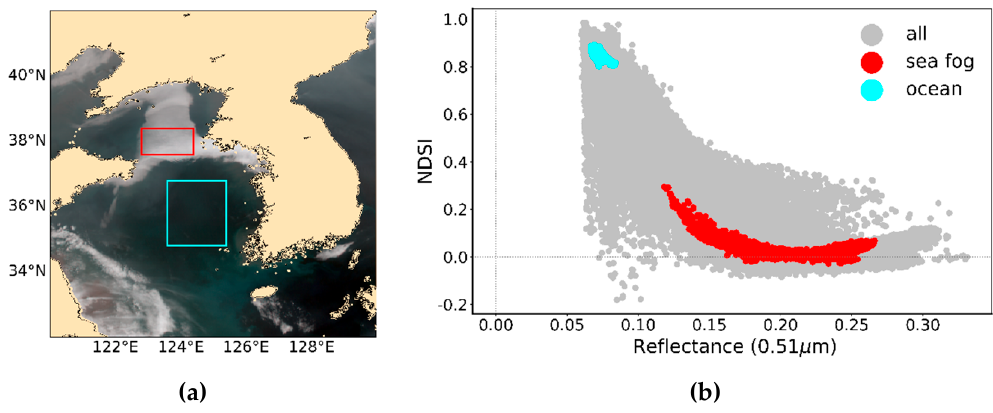
Figure 3. Case study examples. ( a ) AHI true-color images and ( b ) distributions of sea fog and sea surface pixels versus all pixels in the Yellow Sea in ( a ). The pixels in the land area were excluded.